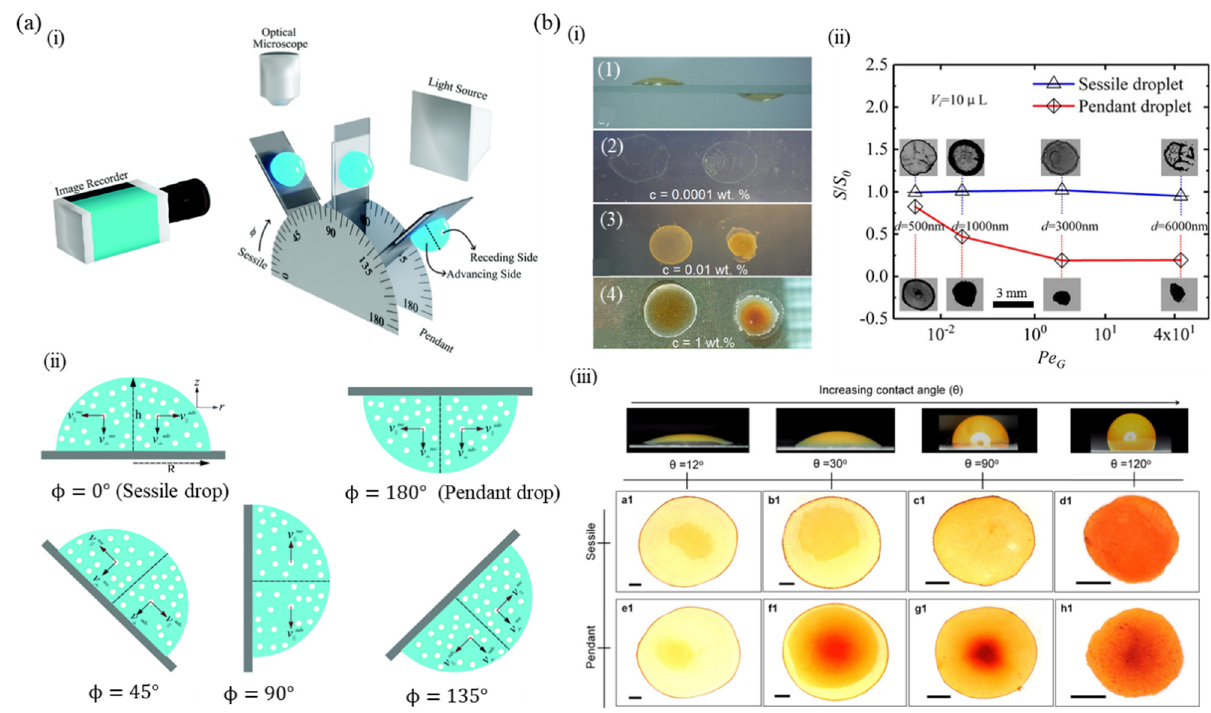
Figure 7. ( a ) (i) Schematic of the experimental set-up used to generate colloidal dispersion drops on substrates placed at different inclinations. CCD camera (image recorder) captures a side view and top view of the drop and an optical microscope is used to study the kinetics of drop evaporation, and (ii) illustrations show the components of velocity experienced by particles in a drop drying at different substrate inclinations: the direction of particle velocity parallel and perpendicular to the substrate in advancing side (respectively labeled as v adv and v adv ⊥ ) and receding side (respectively labeled as v rec and v rec ⊥ ) (reproduced with permission from ref. [147]. Copyright 2021 Royal Society of Chemistry). ( b ) Comparison of patterns obtained from the drying drops of colloidal dispersions in sessile and pendant modes for (i) (1) 22 nm iron oxide particles (initial contact diameter ∼ 8 mm) deposited, and (2), (3) and (4) dried on a glass substrate at different concentrations of 0.0001 wt.%, 0.01 wt.% and 1 wt.%, respectively (reproduced with permission from ref. [141]. Copyright 2011 Elsevier). (ii) Drops (10 µ L) containing PS colloidal particles (0.1 wt.% and initial contact radius of 1.5 mm) of different particle sizes. The scale bar is 3 mm (reproduced with permission from ref. [149]. Copyright 2018 American Chemical Society). (iii) Drops (2 µ L) containing hematite ellipsoids ( ∼ 59 nm diameter, ∼ 244 nm long) at a concentration of 0.12 wt.% on substrates of different wettabilities, namely θ = 12 ± 3 ◦ , 30 ± 5 ◦ , 90 ± 2 ◦ , and 120 ± 5 ◦ . The scale bar is 500 µ m (reproduced with permission from ref. [143]. Copyright 2018 American Chemical